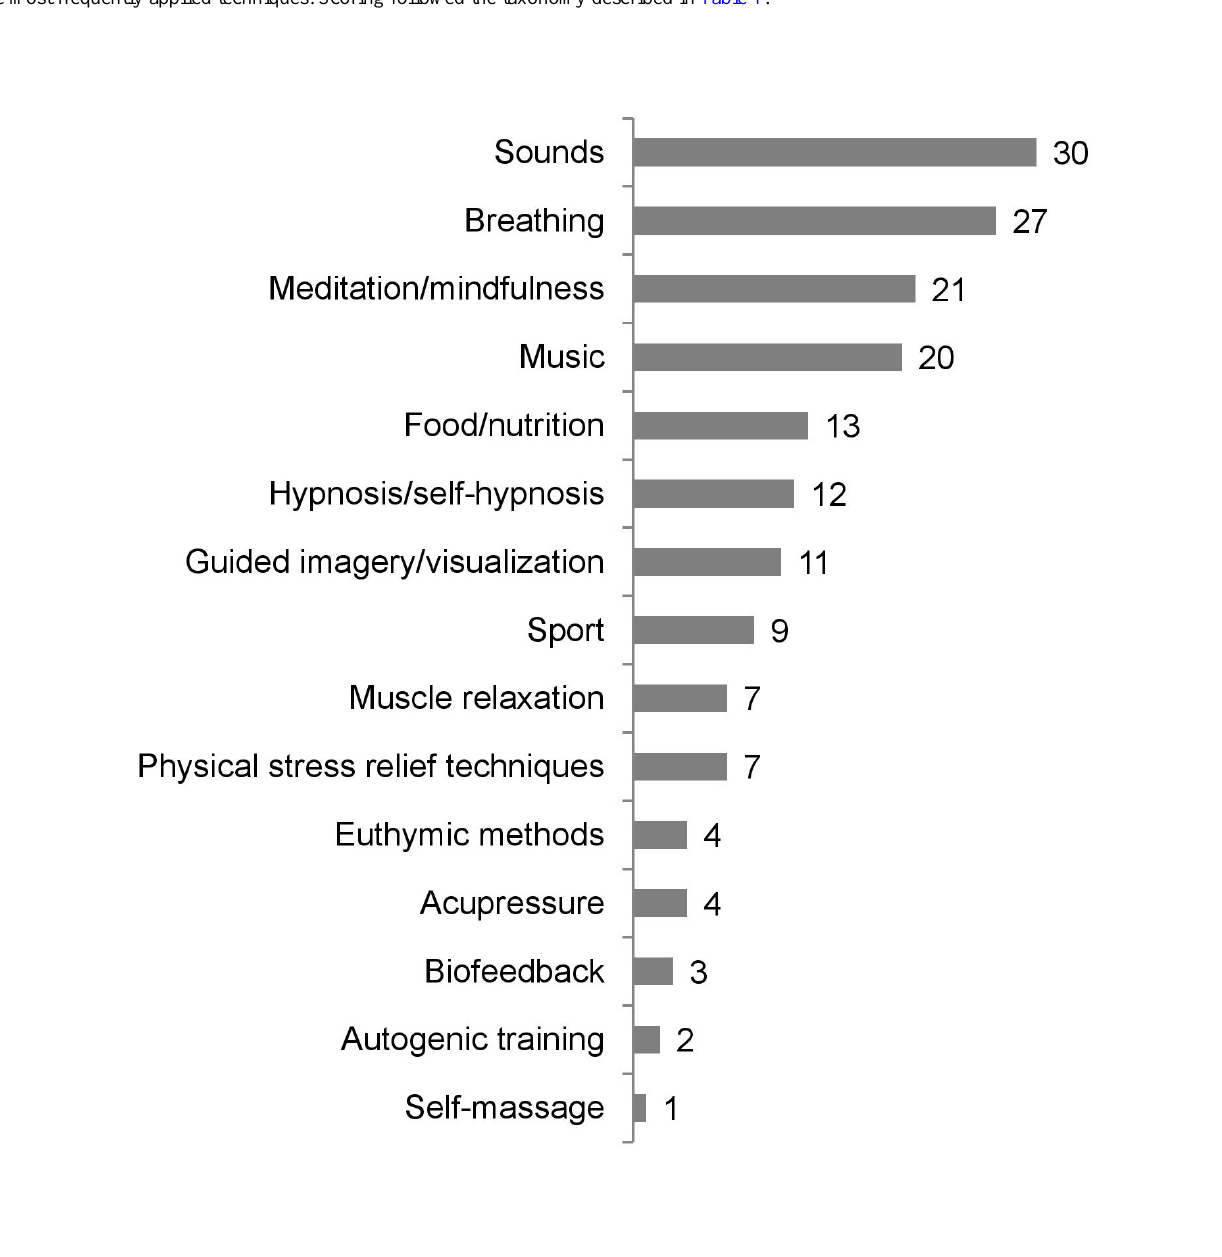
Figure 3. Stress management strategies. Absolute frequencies of the 15 emotion-focused stress management strategies used in the 62 apps, ranked by the most frequently applied techniques. Scoring followed the taxonomy described in Table